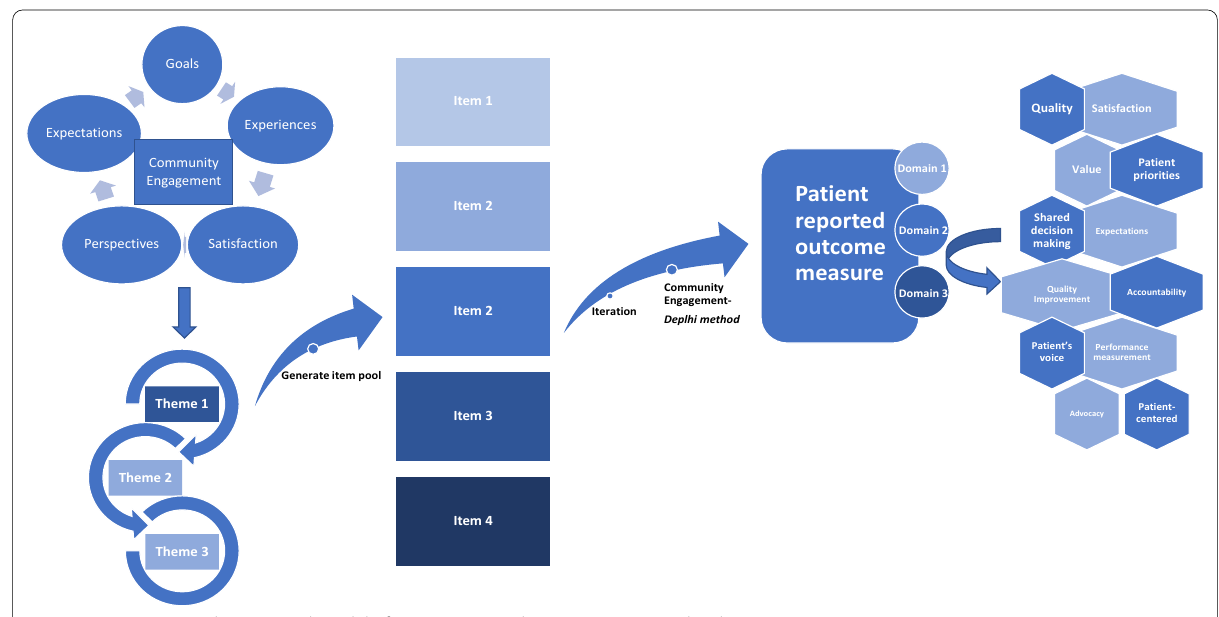
Fig. 1 Patient‑engaged conceptual model of patient reported outcome measure